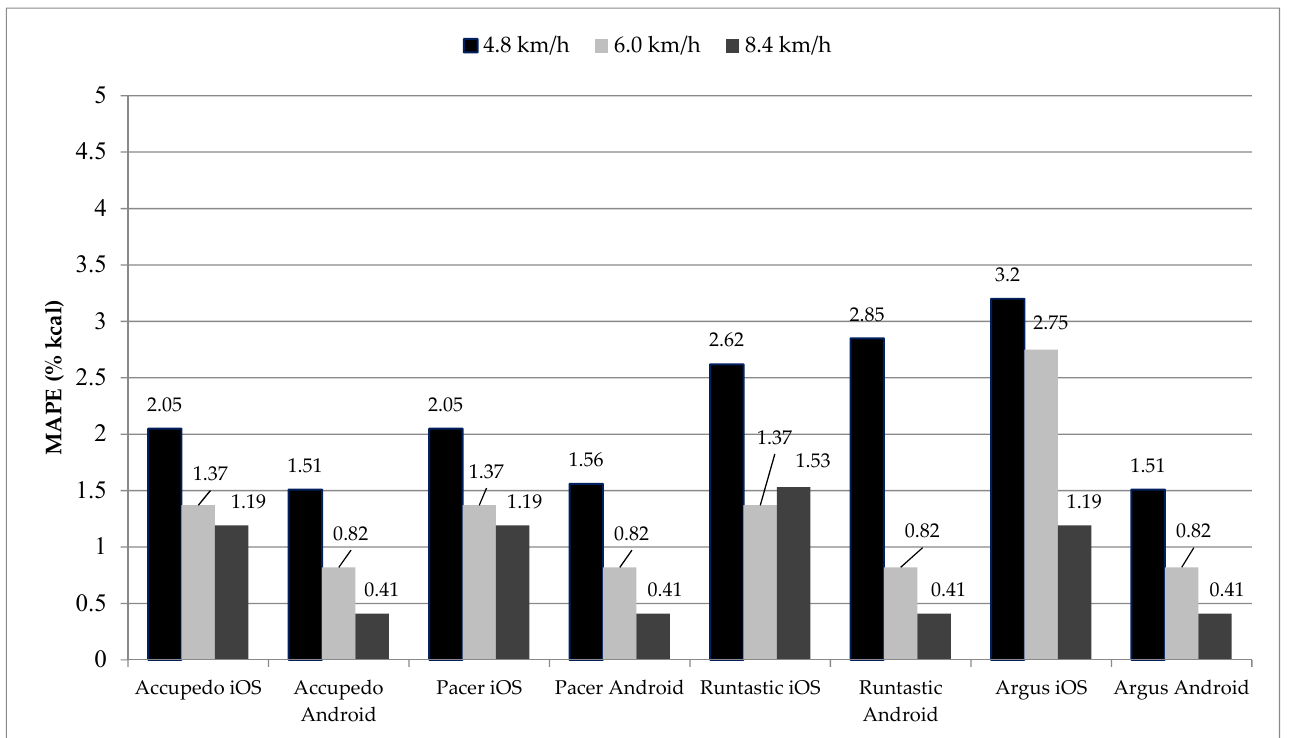
Figure 1. MAPE (% steps) of PA monitors and apps compared with criterion measure. Bland–Altman results for step count for the three conditions are presented in Table 3, and all Bland–Altman plots are included in the Supplementary file (Figures S1–S48). For walking at 4.8 km/h, the plots revealed the narrowest 95% limits of agreement for Accupedo Android and Argus Android (difference = 3.50 steps), while values were the widest for Runtastic iOS (difference = 10.90 steps) and Argus iOS (difference = 14.23 steps). During walking at 6.0 km/h and jogging at 8.4 km/h, the narrowest 95% limits of agreement were observed for all Android apps (difference = − 2.57 and − 0.77 steps, respectively), and values were wider for all iOS apps. The widest values were observed for Argus iOS at 6.0 km/h (difference = 15.30 steps) and Runtastic iOS at 8.4 km/h (difference = 8.53 steps). The slopes for the fitted lines were not statistically significant (p < 0.05), suggesting